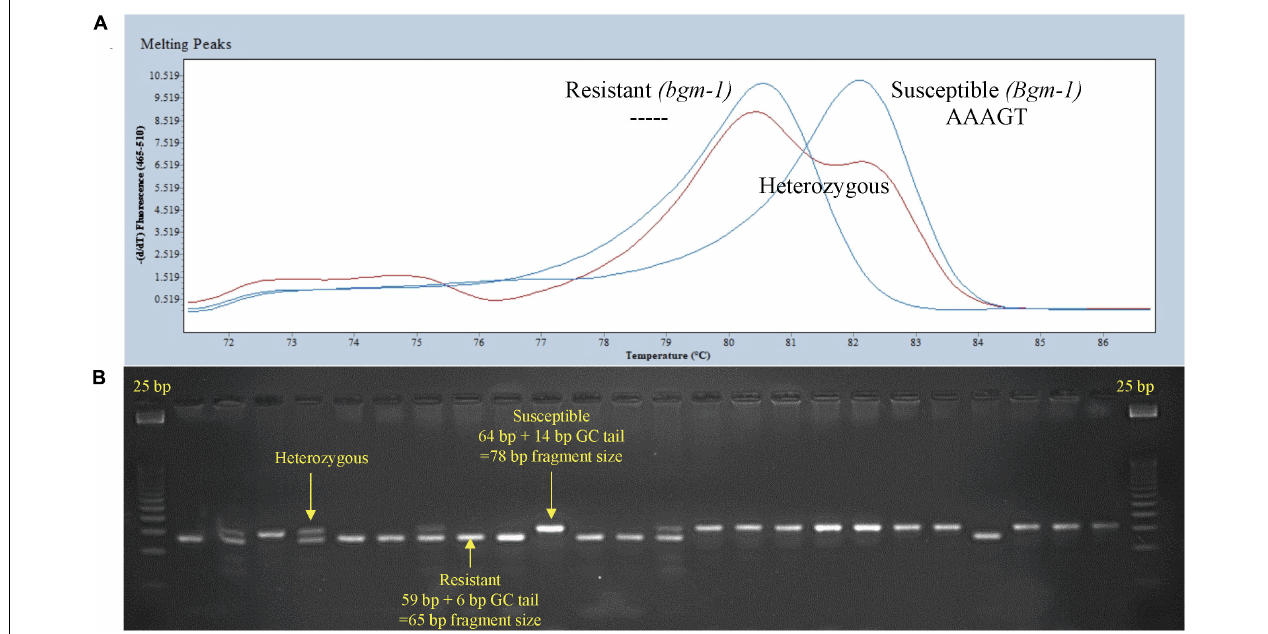
FIGURE 2 | The CB_475_v3 marker developed for the five bp indel region in exon 2 of the candidate. (A) Phvul.003G027100 NAC gene for bgm-1 visualized by melting curve Tm-shift assay and (B) by gel electrophoresis.